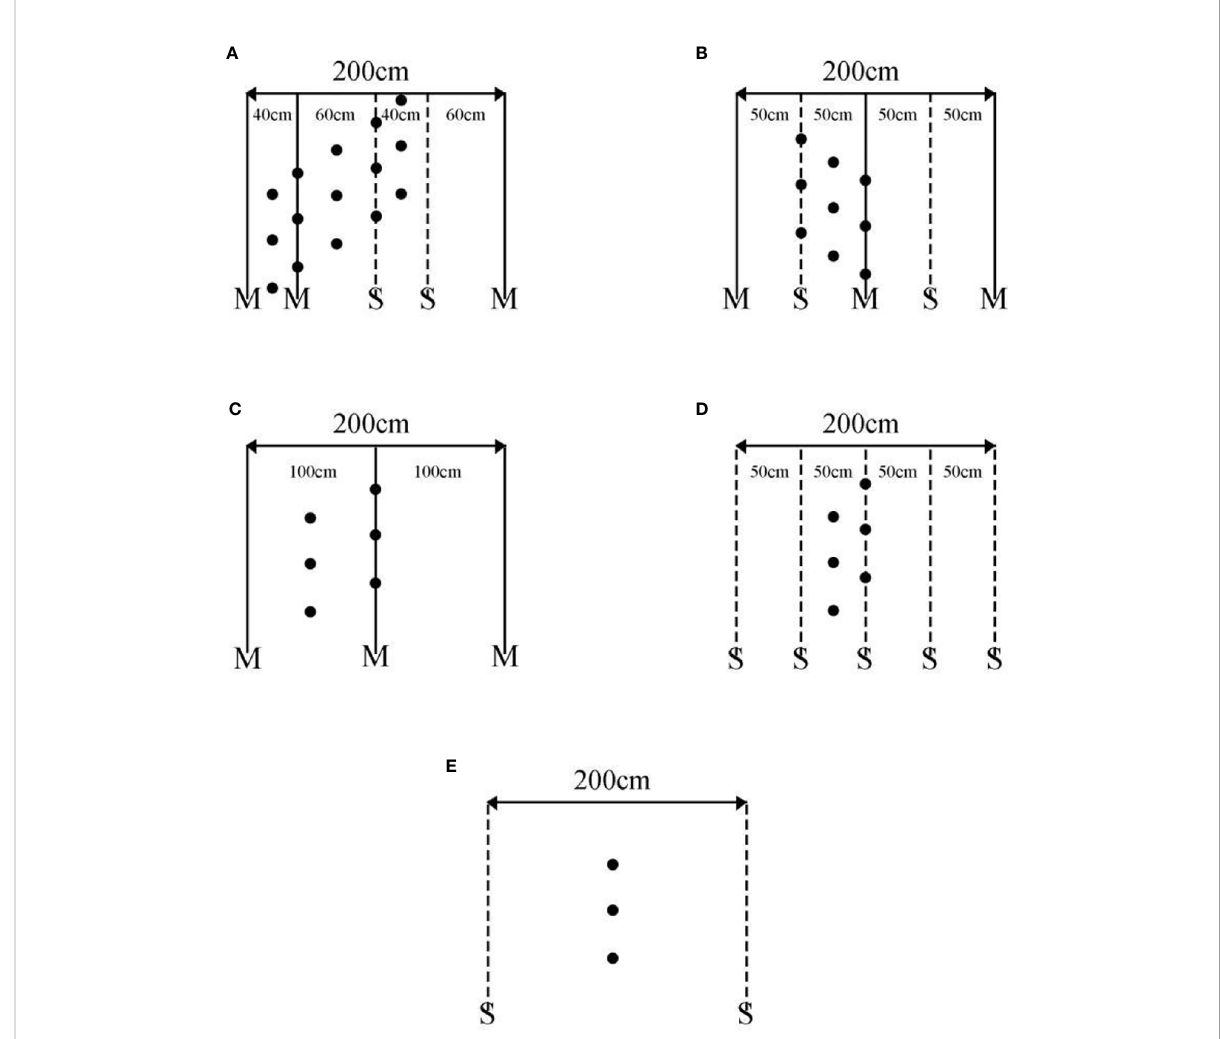
FIGURE 3 Spatial distribution of soil sample sites in different cropping patterns. (A) Maize/soybean relay strip intercropping (continuous and rotation cropping), (B) traditional maize/soybean intercropping, (C) maize monoculture, (D) soybean monoculture, and (E) fallow land. M, sole maize planting; S, sole soybean planting; ● , for the soil sample collection